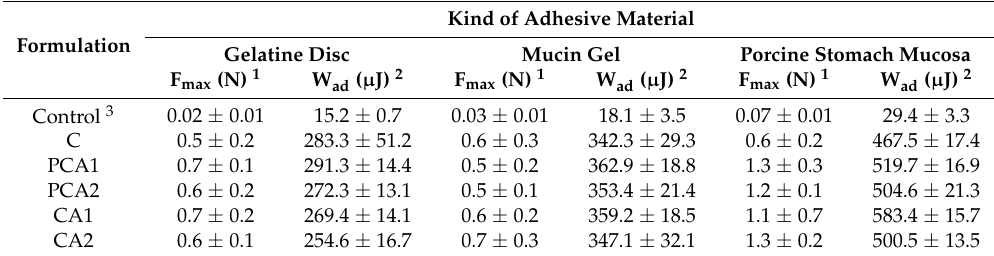
Table 4. Mucoadhesive properties of designed microparticles.